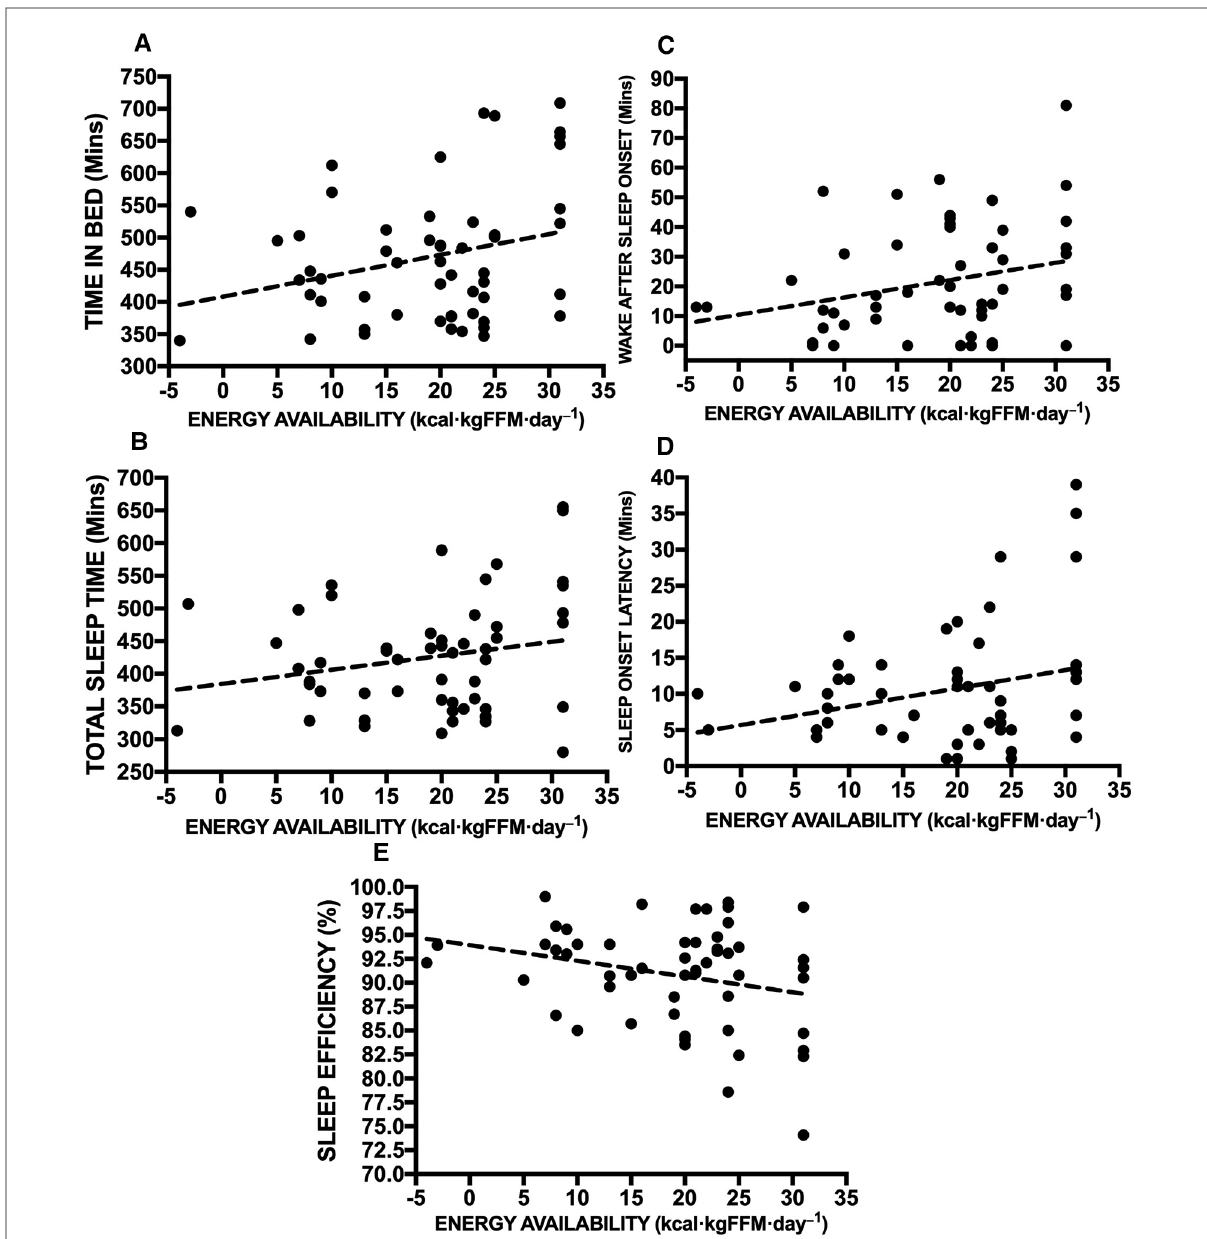
FIGURE 2 Rank correlation coef fi cient assessments between daily energy availability status and sleep measures inclusive of TIB ( A ), TST ( B ), WASO ( C ), SOL ( D ) and SE ( E